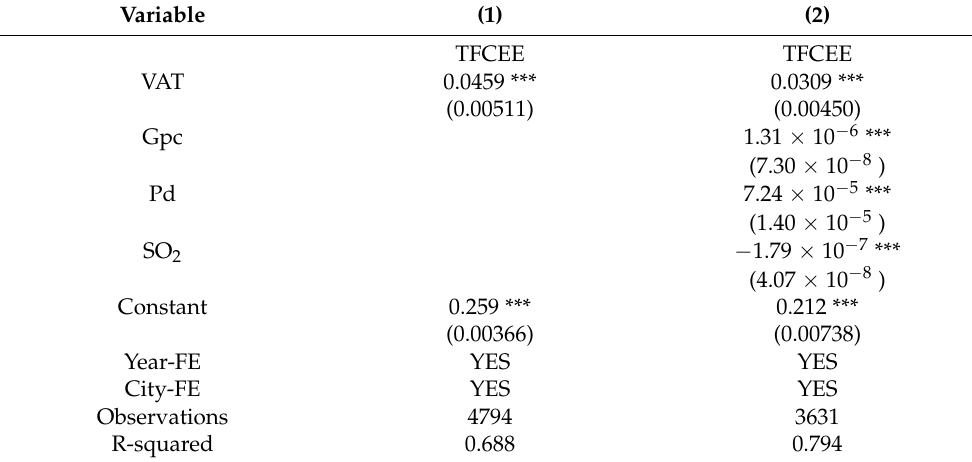
Table 4. The baseline results of the impacts of VAT reform on